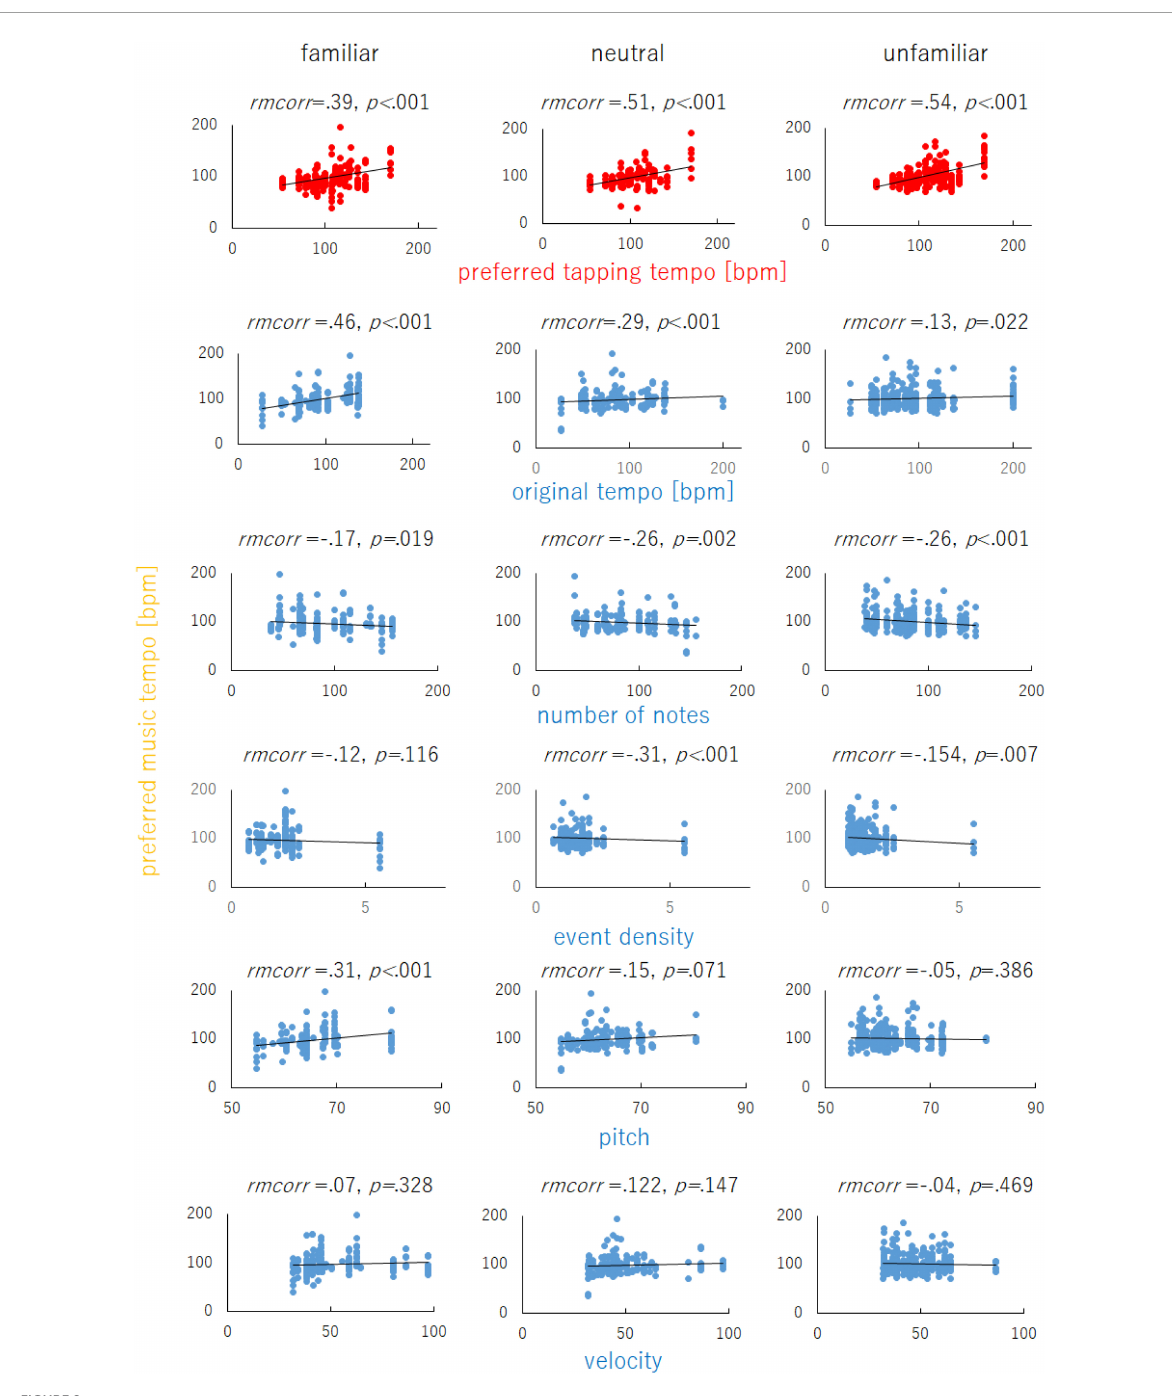
in any of the familiarity categories [familiar: t (45.05) = − 0.58, p = 0.566; neutral: t (53.97) = 0.32, p = 0.747; unfamiliar: t (41.3) = 0.22, p = 0.831]. There was no significant main